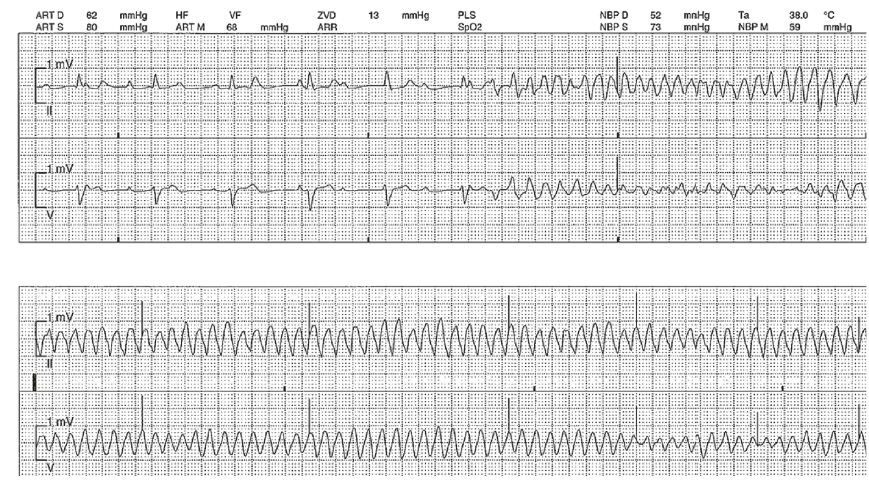
Figure 2: Monitor recording of episode of sudden cardiac